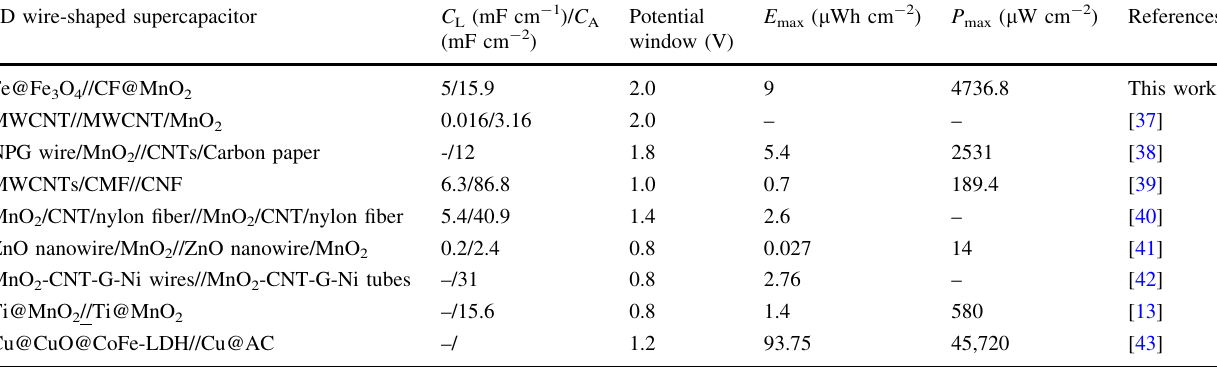
Table 1 Performance summary of recent reports about one-dimensional wire-shaped supercapacitor 1D wire-shaped